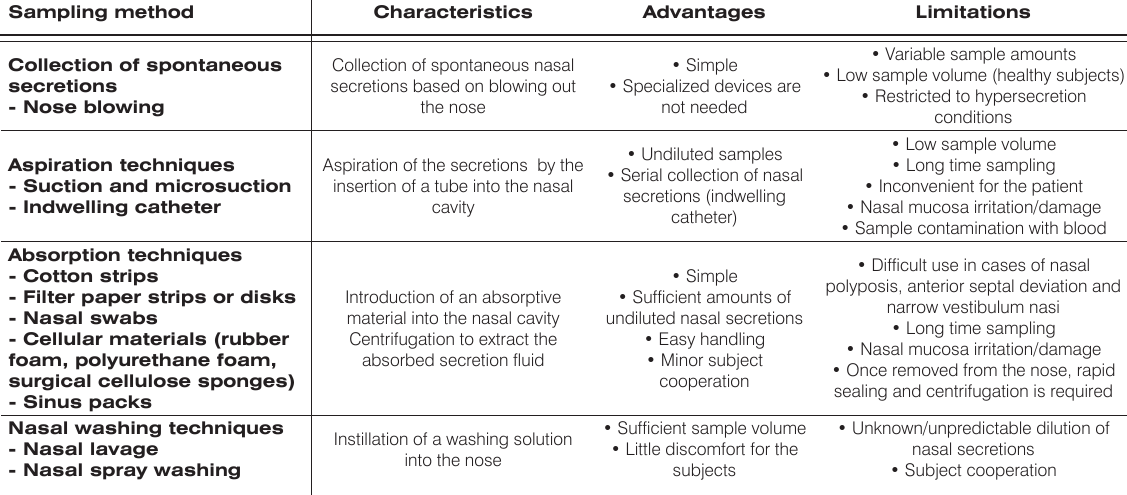
Table 1. Advantages and limitations of sampling methods used to collect nasal secretions [51,85-87,90,92]. Sampling